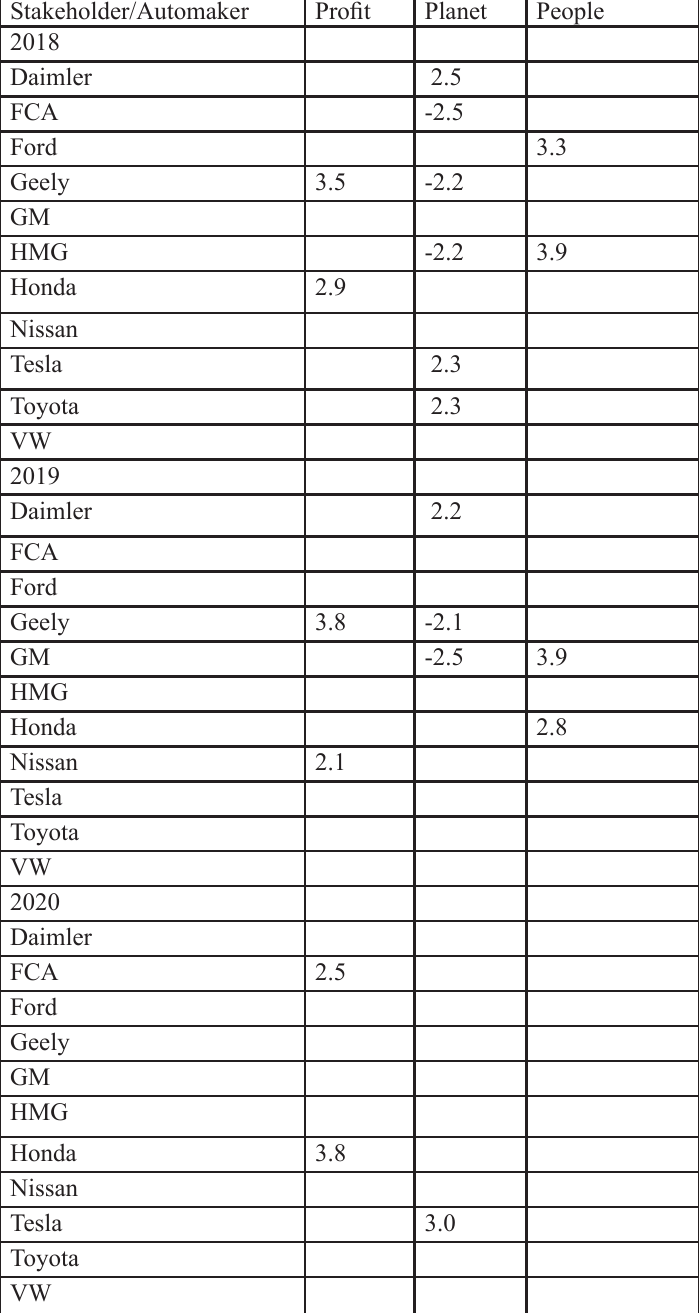
Table 3: Significant Adjusted Standardized Residuals of CSR Goals by